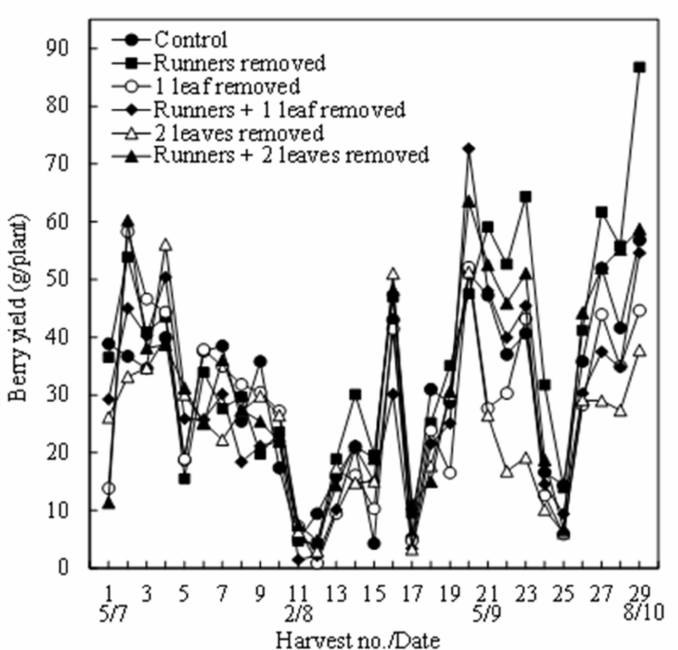
Figure 3. Time course of berry yield per harvest (g per plant, average of three replicates with six plants each) in the everbearing strawberry cv. ‘Favori’ depending on bi-weekly removal of runners and leaves during the